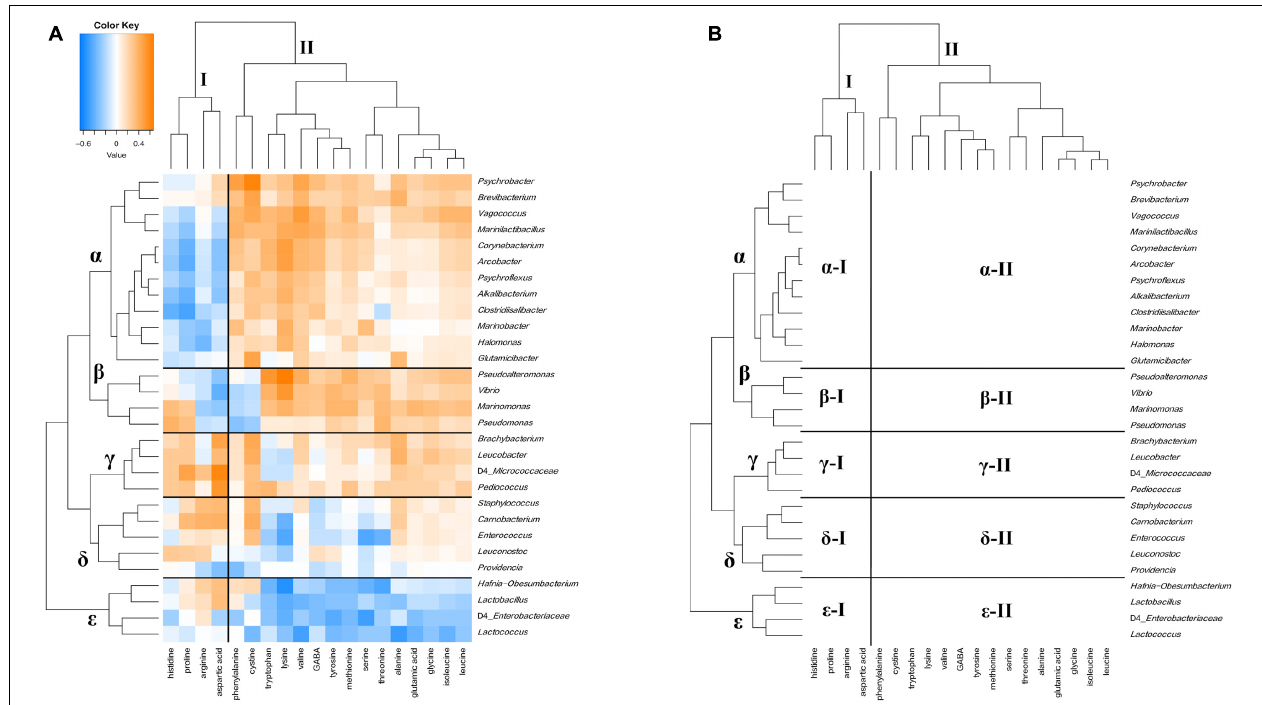
FIGURE 10 | Hierarchical clustered map showing the Spearman correlation between bacteria genus and free amino acids detected on 30 cheese samples. (A) Spearman correlation heat map. Orange indicates positive correlation and blue indicates negative correlation. (B) Hierarchically clustered map. Free amino acids clusters are represented by I, II, and III. Bacteria clusters were represented by α , β , γ , δ , and ε